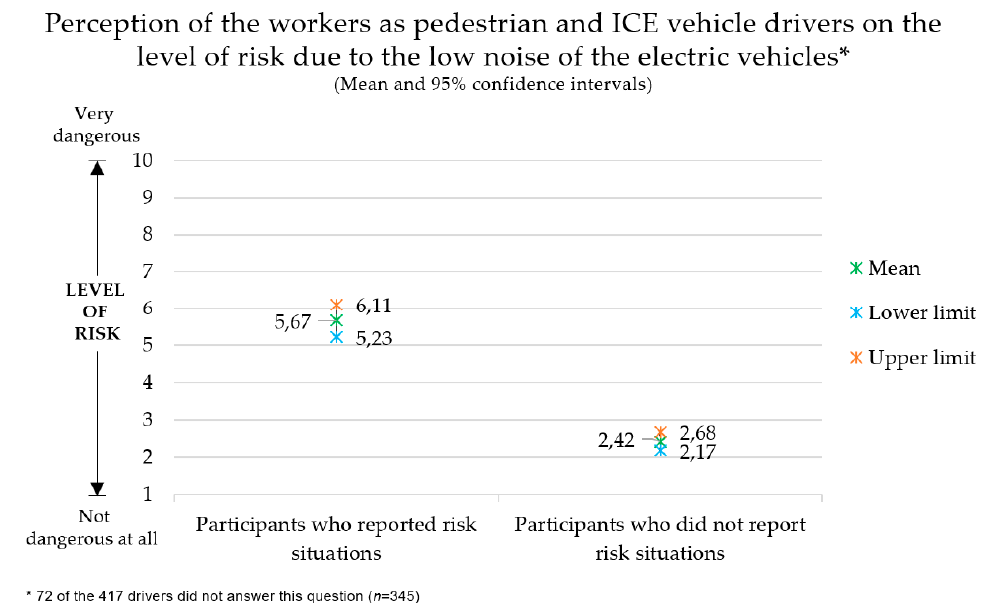
Figure 4. Level of risk of situations that could be caused by the low noise emissions of EVs, assessed by workers as pedestrians and internal combustion engine vehicle drivers (n = 346).